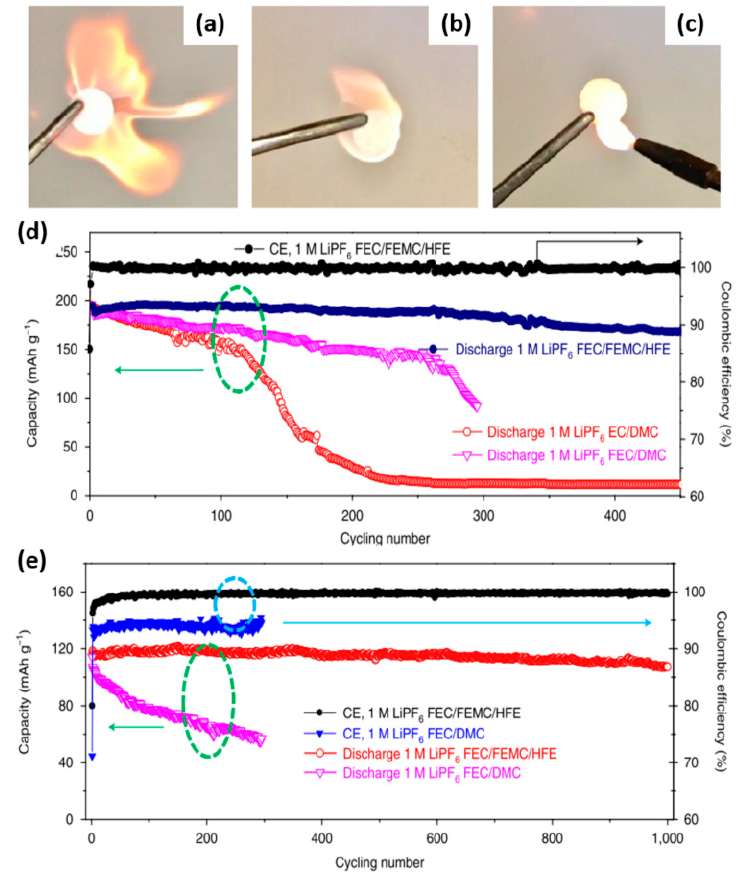
Figure 4. Flammability test for ( a ) 1 M LiPF 6 /EC/DMC, ( b ) 1 M LiPF 6 /FEC/DMC, and ( c ) 1 M LiPF 6 /FEC/FEMC/HFE, ( d ) Cycling stability at 0.5C; ( e ) cycling stability at 1C [26]. Reprinted with permission from Springer Nature, Nature; X. Fan, L. Chen, O. Borodin, X. Ji, J. Chen, S. Hou, T. Deng,